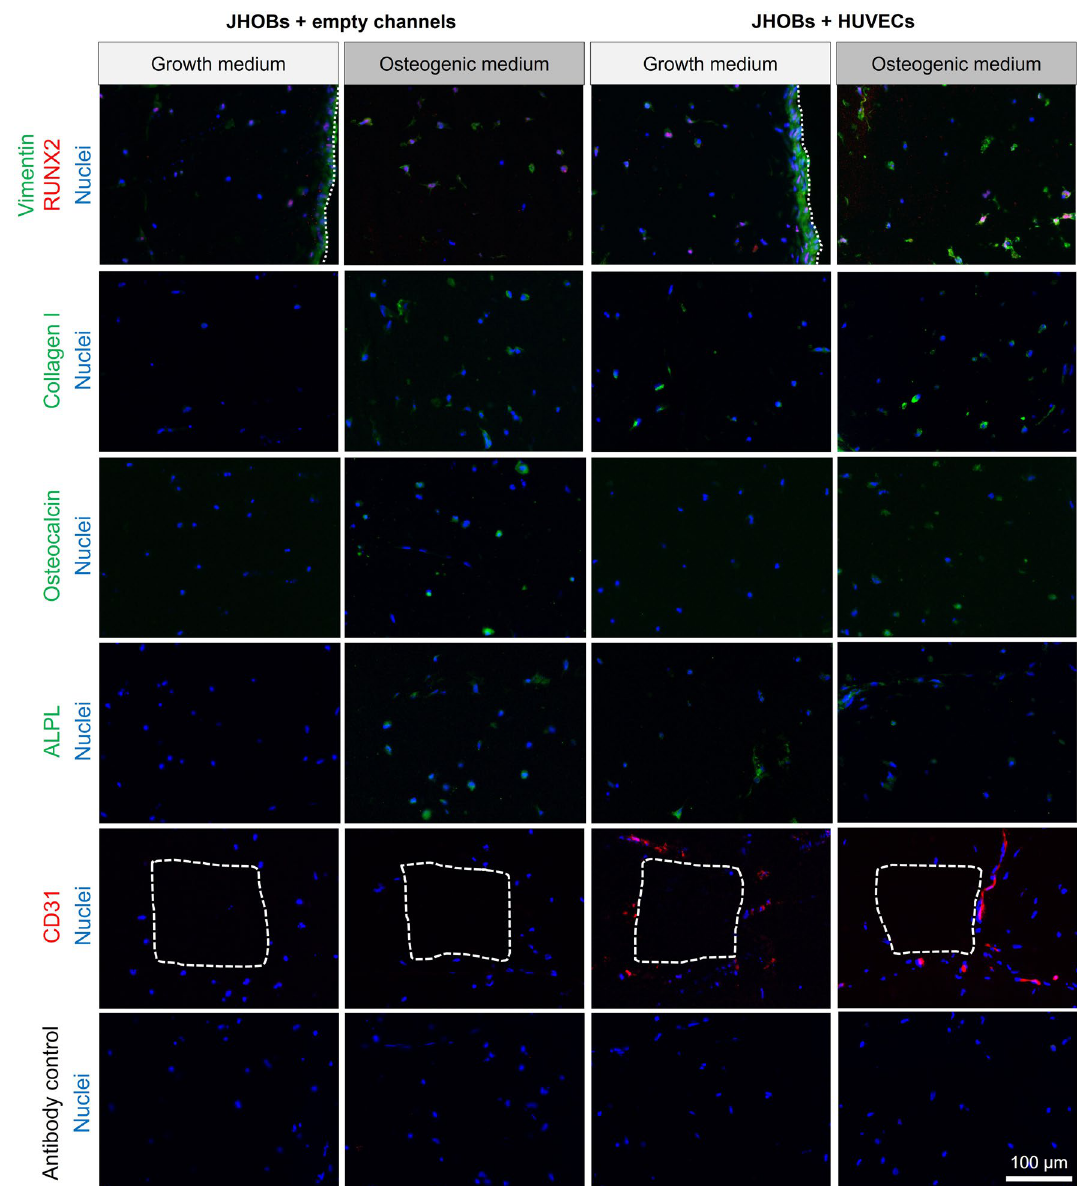
Figure 6. Immunohistological staining of the bioprinted human jawbone models. Cryosections were stained for osteoblast (RUNX2 (Runt-related transcription factor 2), collagen I, osteocalcin, ALPL (alkaline phosphatase)) and endothelial cell markers (CD31), in cell-laden constructs containing JHOBs and optionally also HUVECs after 28 days of cultivation in growth and osteogenic medium. Channels are marked with white dashed lines (CD31 staining), and the surface of the constructs is marked with white dotted